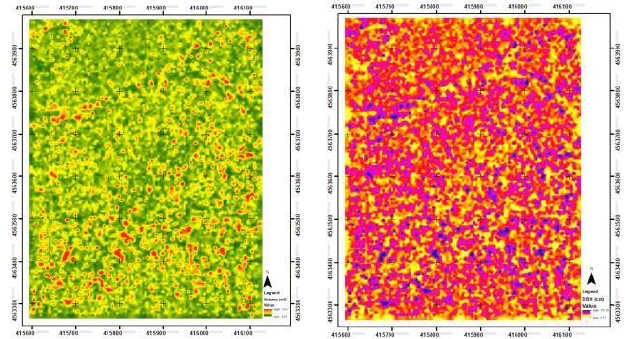
Figure 5. Volume and DBH thematic mapping for F21c053c map sheet The selected map sheet of F21c05c3c at 1/1000 scale